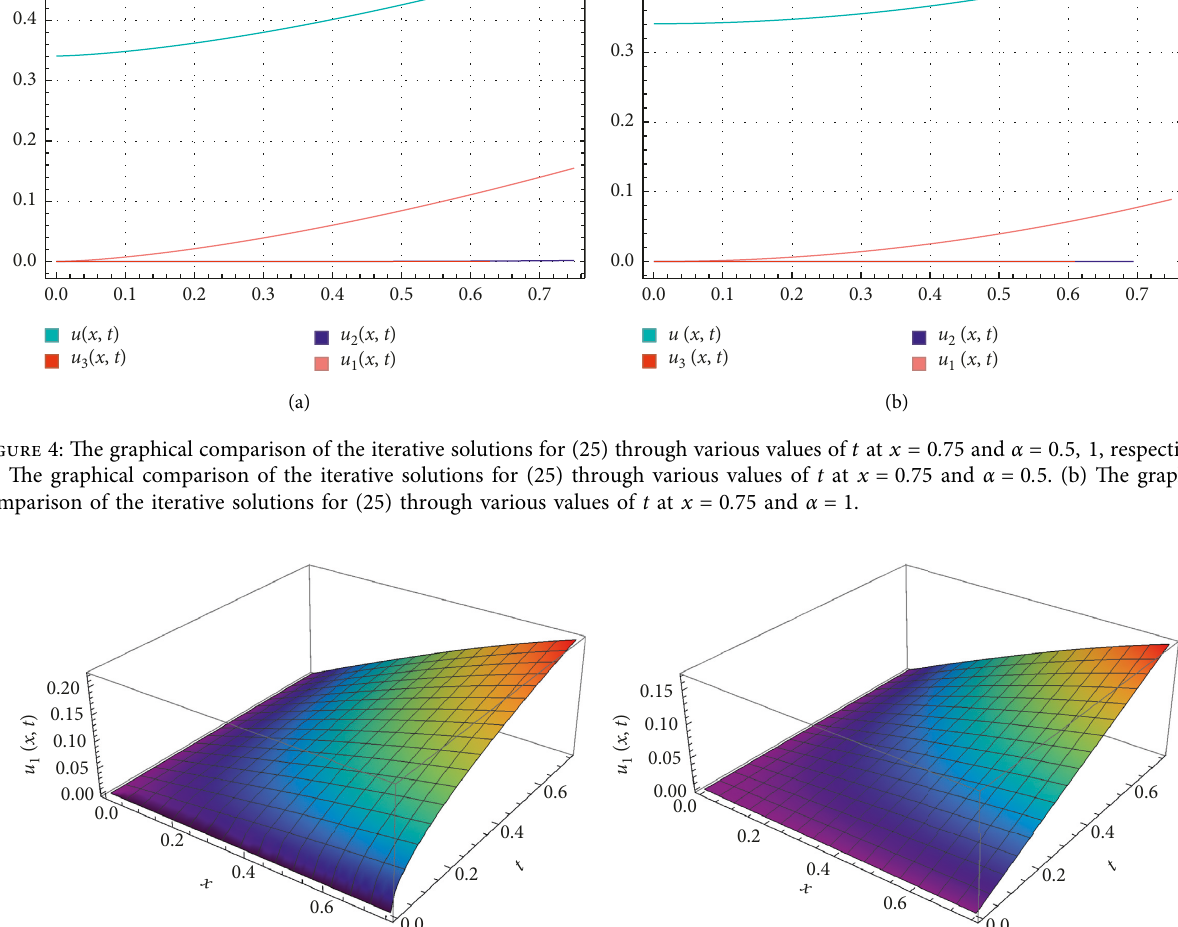
Figure 5: The graphs of the first-order iterative solution u ( x, t ) for (30) through various values of x,t at α � 0 . 5 , 1, respectively. (a) The 1 ( x, t ) for (30) through various values of x,t at α � 0 . 5. (b) The graph of the first-order iterative graph of first-order iterative solution u 1 ( x,t ) for (30) through various values of x,t at α � 1. solution u 1